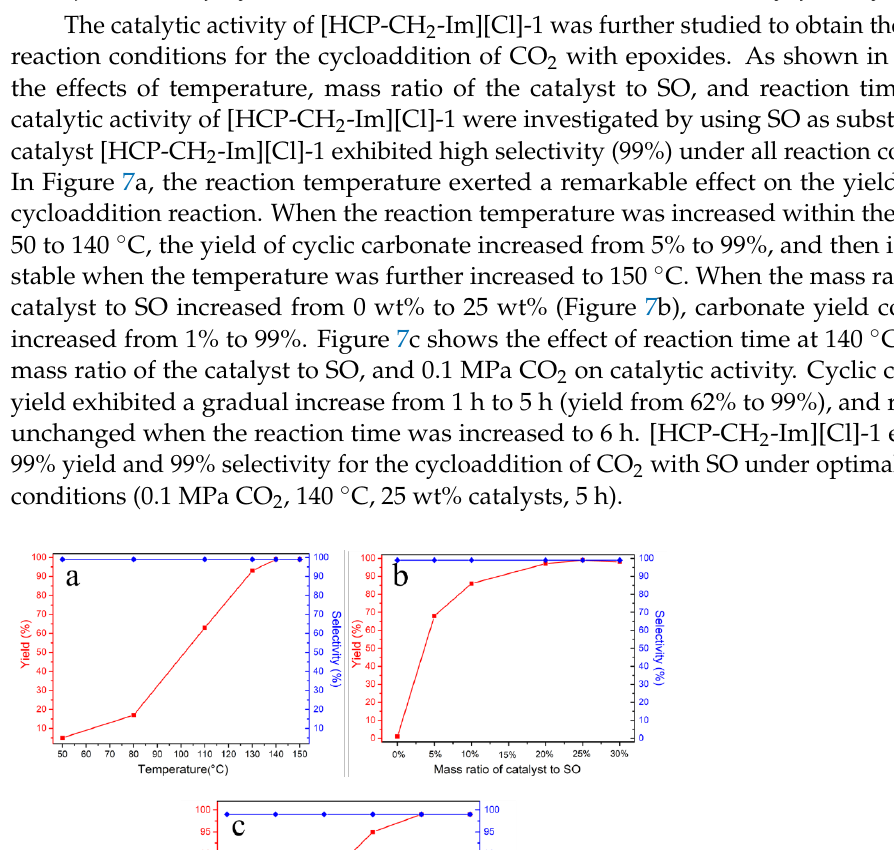
Figure 6. ( a ) N 2 adsorption-desorption isotherms, ( b ) pore size distribution of [HCP-CH 2 -Im][Cl]- X.